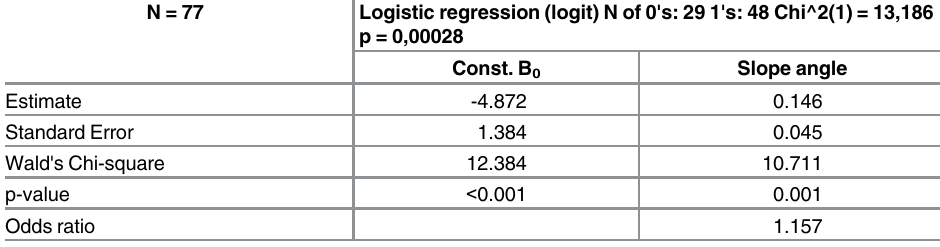
Table 4. Logistic regression results — model 2.